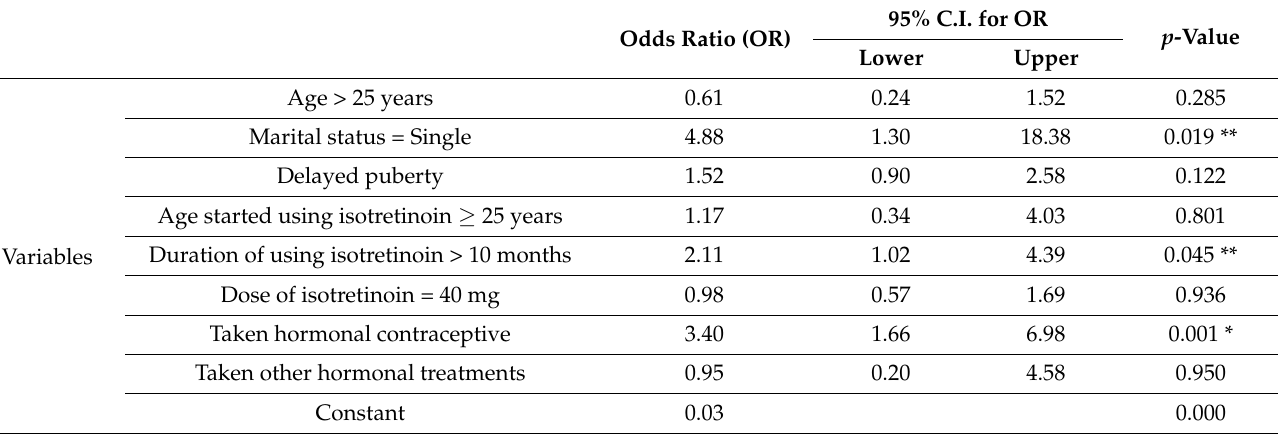
Table 4. Logistic